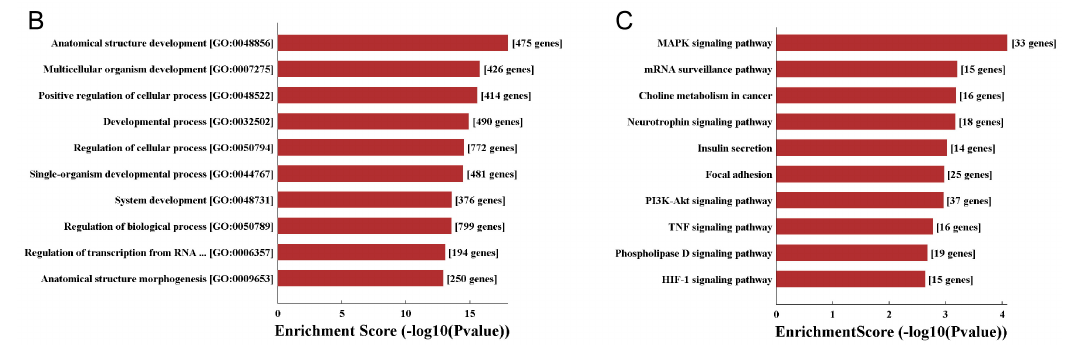
Figure 2. Gene Oncology (GO) and Kyoto Encyclopedia of Genes and Genomes (KEGG) pathway analysis in the circRNA signature related to AML risk-status; ( A , B ) GO enrichment corresponds to the five altered circRNAs related to AML risk-status; ( C ) KEGG pathway analysis corresponds to the five altered circRNAs related to AML risk-status.